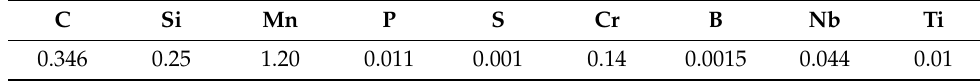
Figure 1. Welding joint preparation. Table 1. Chemical composition of the base metal